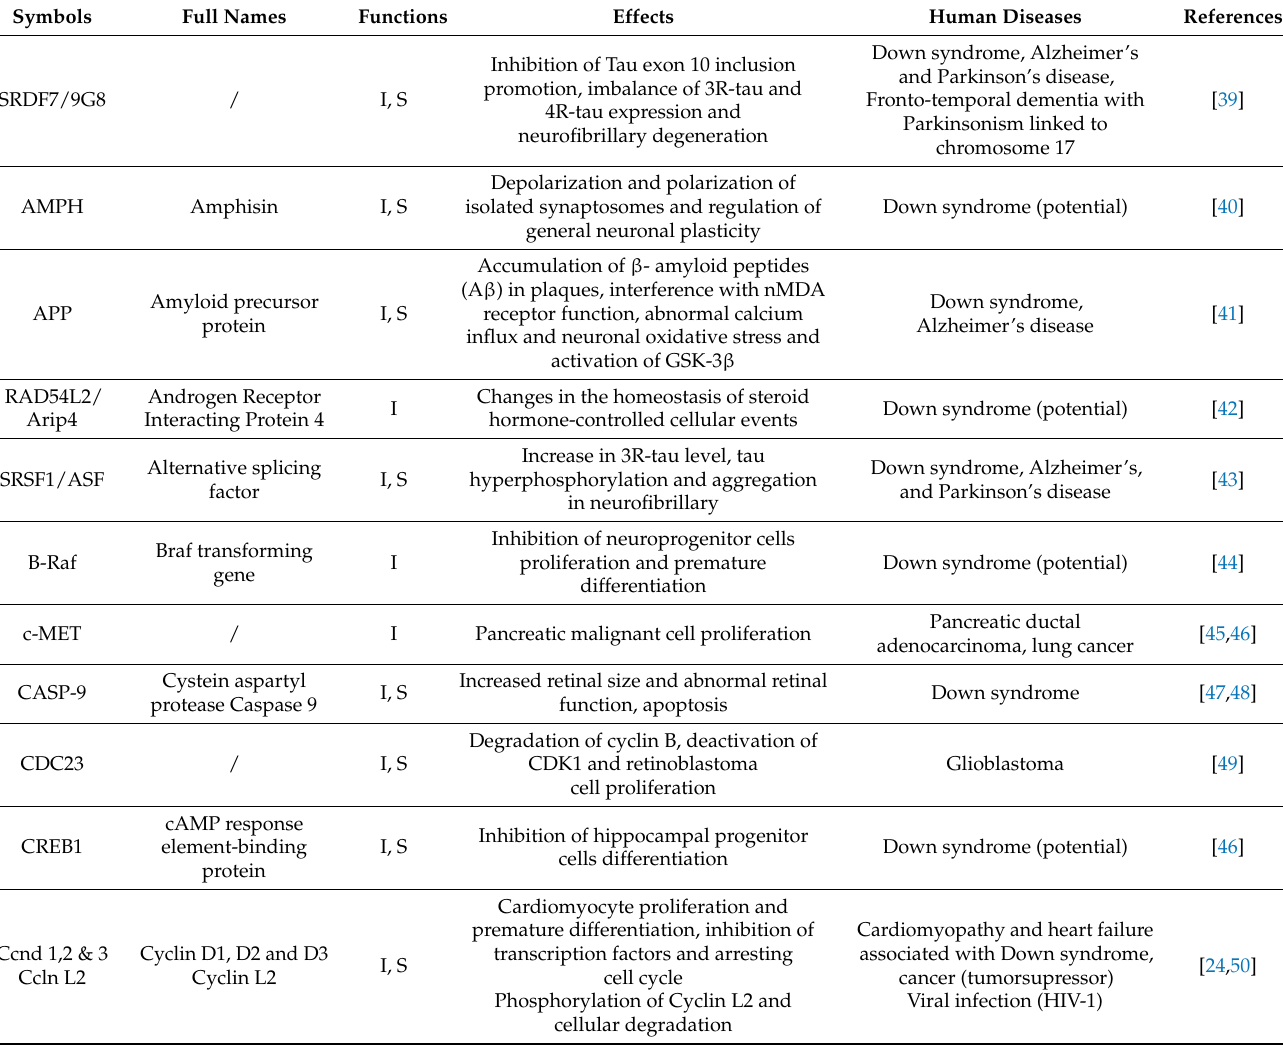
Table 1. Proteins targeted by DYRK1A, associated or potentially associated with human diseases and acting as interactor (I) and/or substrate